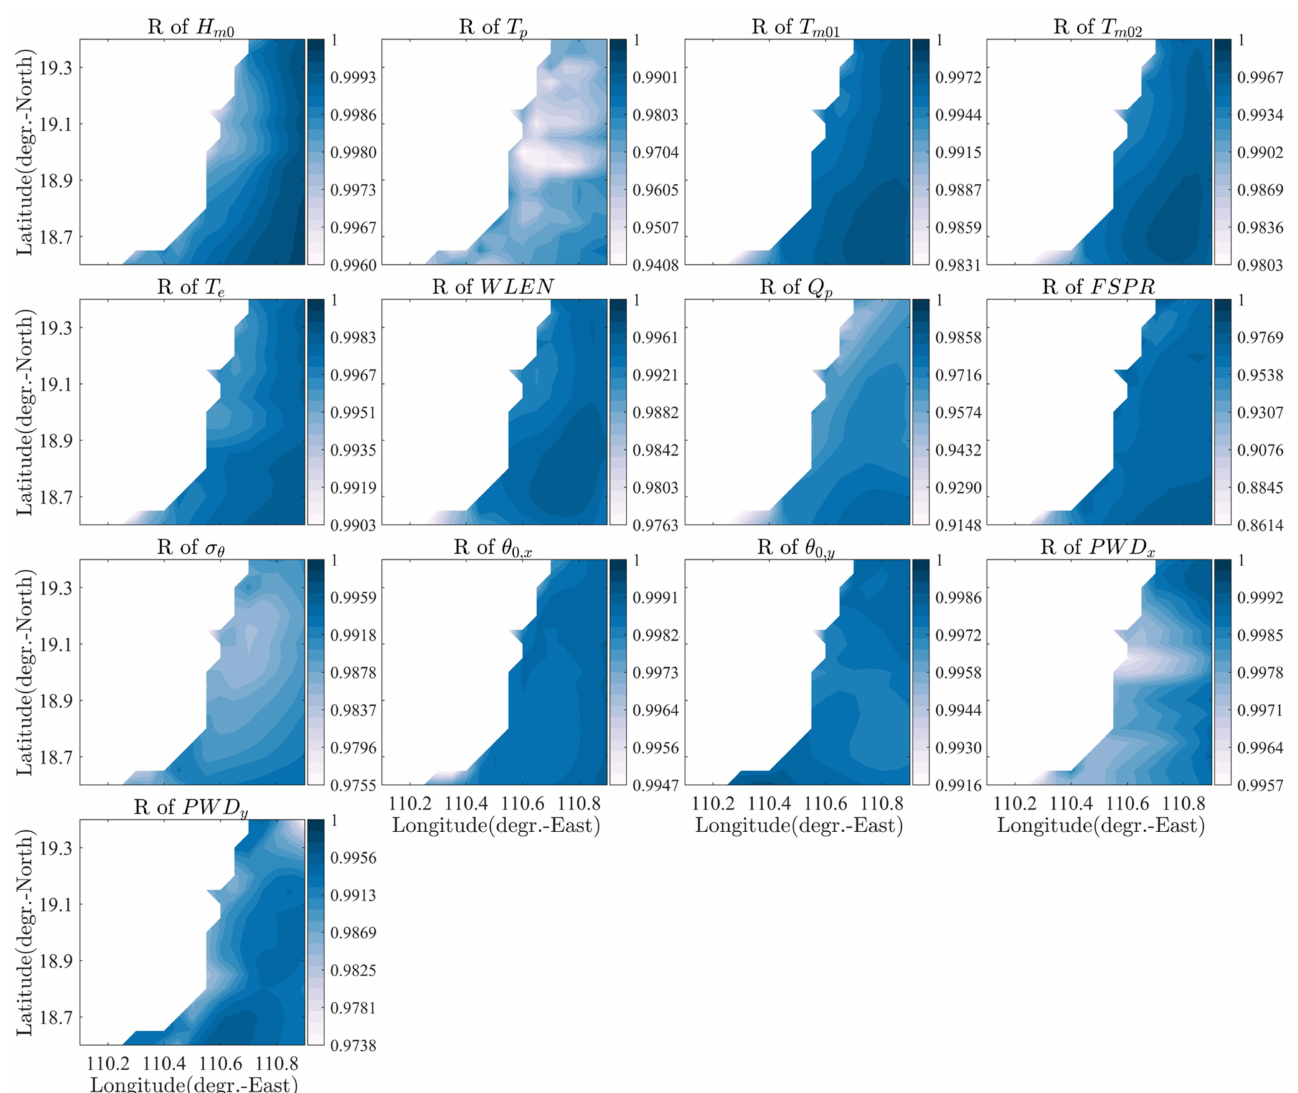
Figure 5. Spatial distributions of correlation coefficient R of the KPs derived from the SWAN BLOCK outputs. In each panel, the values of R are indicated by the colors, the title identifies the corresponding KP, and the x and y axes denote the longitude ( ◦ E) and latitude ( ◦ N), respectively. The partition groups identified at check point O1 are illustrated in Figure 7, where the f – θ spectral space is presented in polar coordinates, as in Figure 1, but where the colors in Figure 7 indicate the number of peak occurrences in the f – θ cells. At least seven groups are identified for the spectrum series derived separately from the original and the reconstructed boundary forcing simulations, and those groups are labeled 1–7 and ordered from large to small based on the peak-occurrence numbers, and the boundaries of the groups are depicted by the white